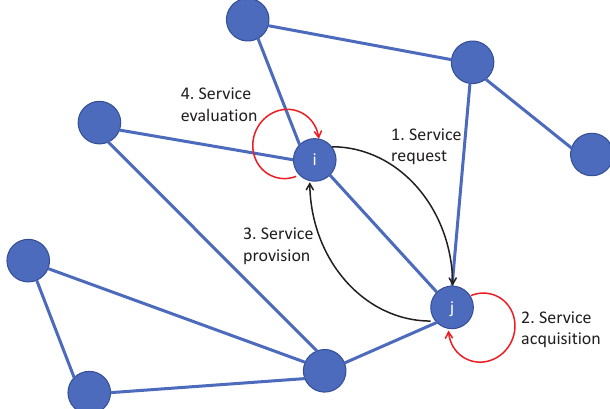
Figure 2. Trust management system—general